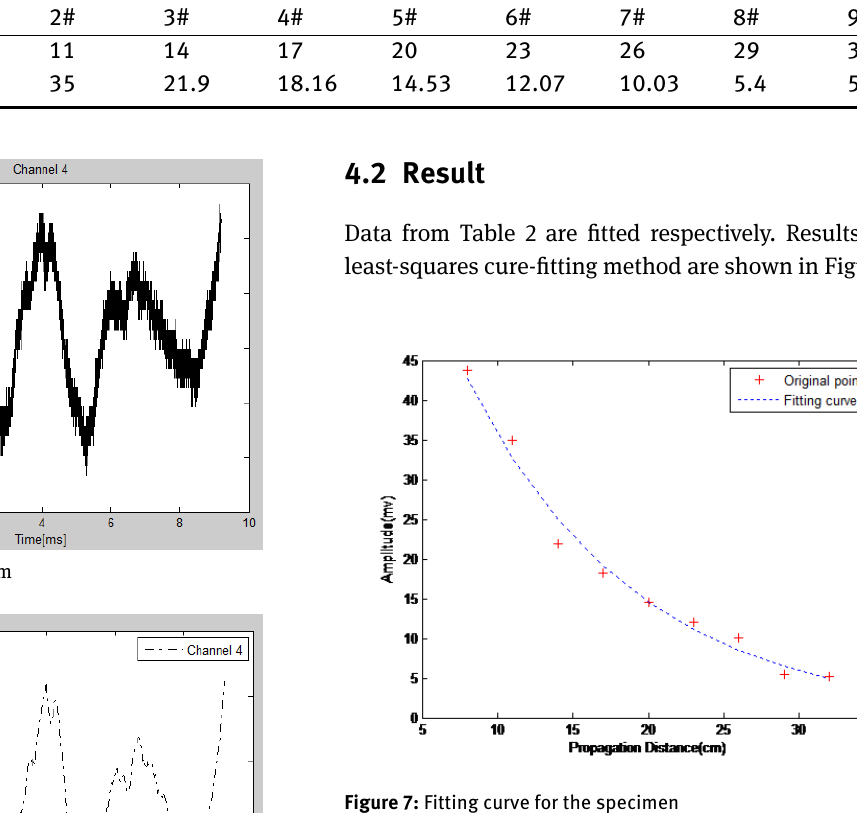
The calculated B and α coefficient of the specimen are 87.3397 and 0.0895, respectively. ER = | (( R − F )/ F ) * 100 | is an error